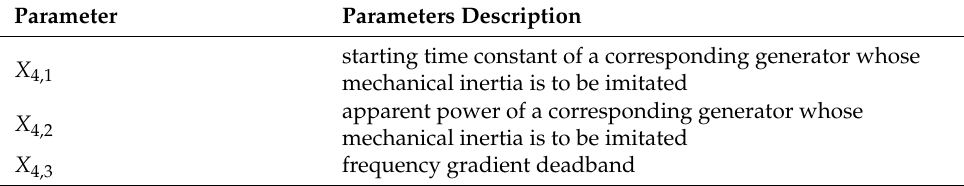
Table A3. Parameters X 4 of function F 4